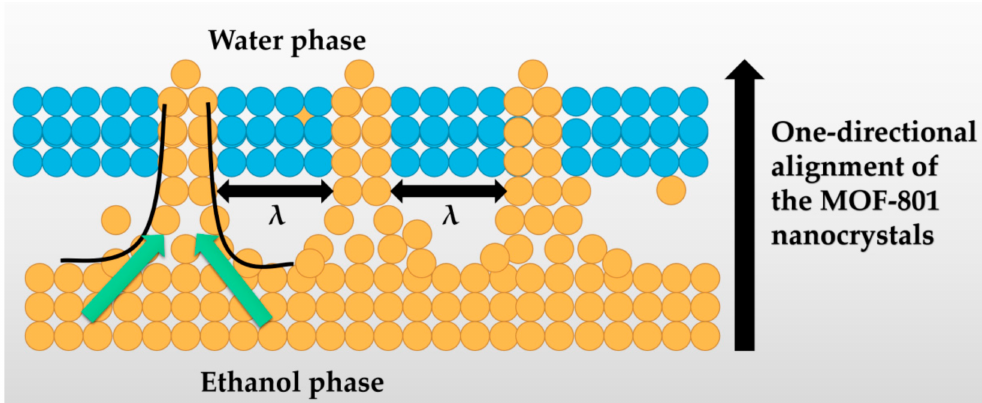
Figure 8. Schematic illustration of the Marangoni flow between ethanol and water